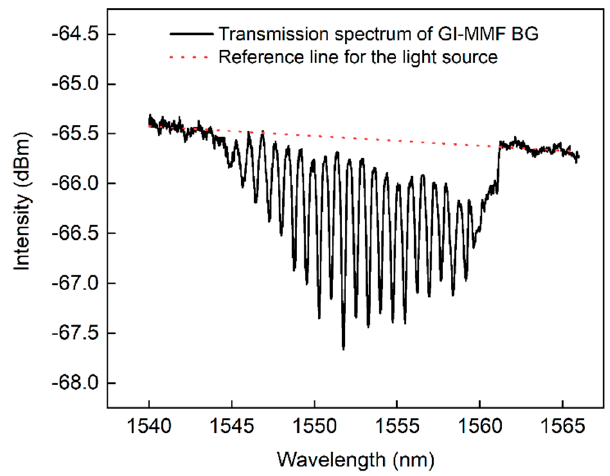
Figure 2. Measured transmission spectrum at a temperature of 20 °C of a BG written in OM4 GI-MMF using the phase mask technique. The red dashed line shows the reference intensity level of the applied light source.